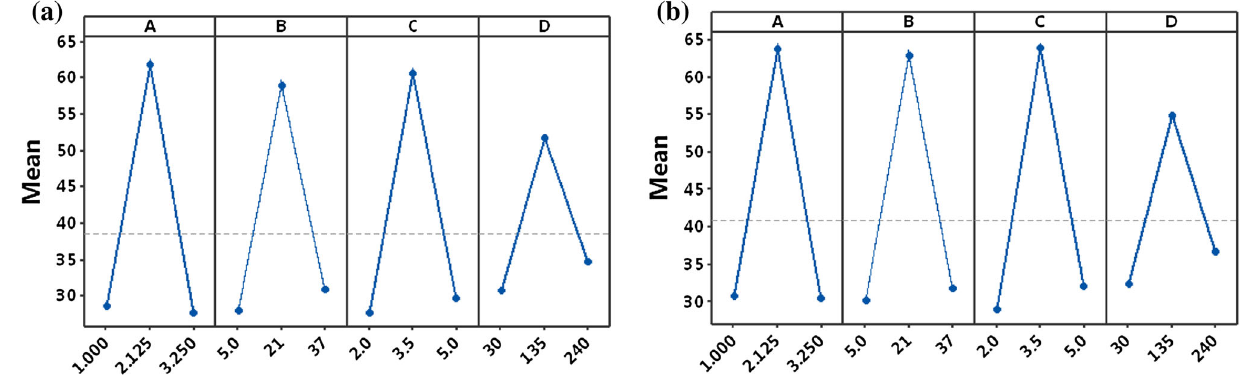
Fig. 4 Main effects plots for both responses a % COD removal efficiency, b % dicamba removal efficiency